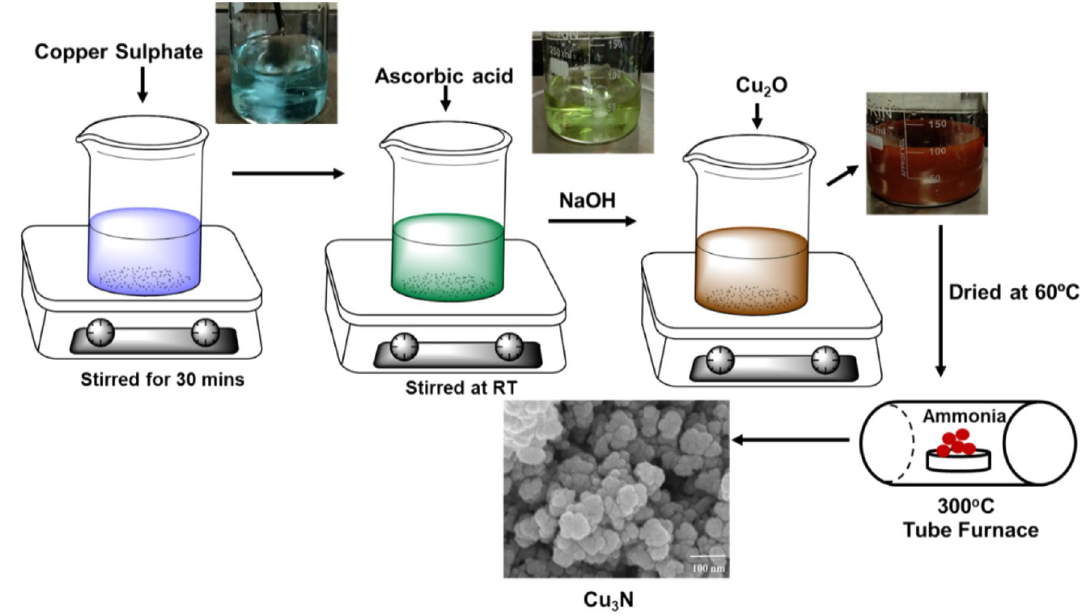
Figure 1. A schematic of the preparation of Cu 2 O and Cu 3 N